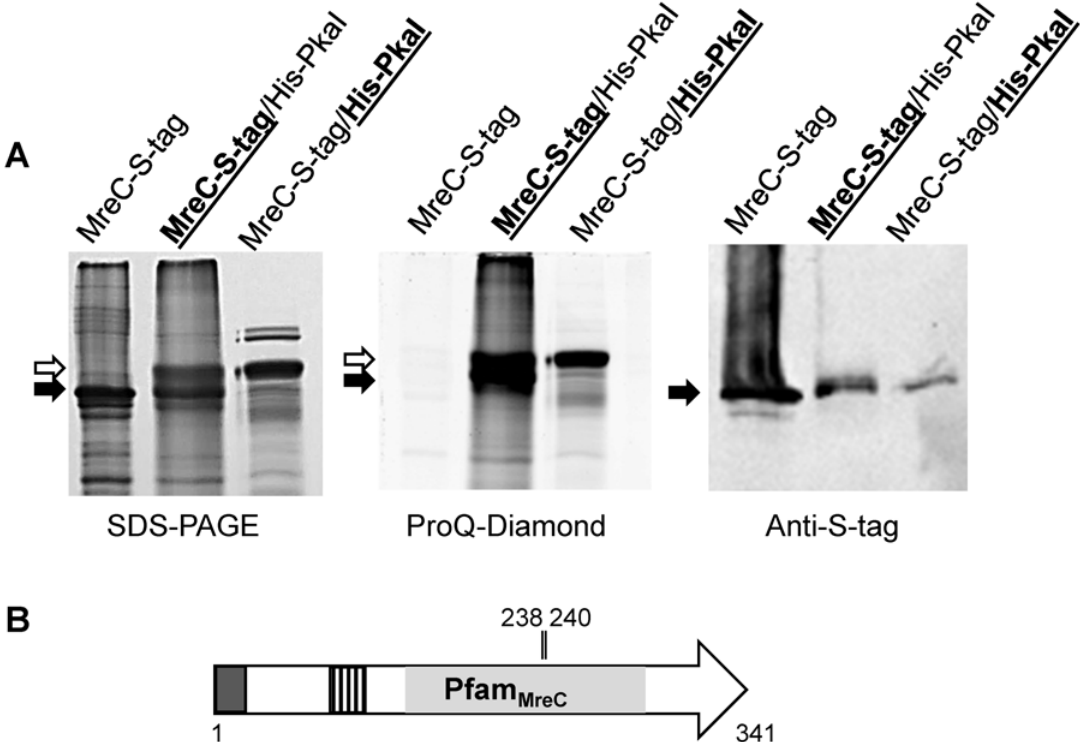
Fig 4. Phosphorylation of MreC by PkaI. S . coelicolor mreC with a S-tag encoding sequence was expressed in E . coli in the absence or presence of pkaI and purified by affinity chromatography (A). PkaI with an N-terminal His-tag was purified by Ni-NTA chromatography in the presence of mreC . Proteins (bold letters and underlining indicate, which protein was purified) were separated on a SDS polyacrylamide gel and stained with Coomassie blue. Purified MreC_S- tag (black arrow) contained considerable amounts of co-purified PkaI (white arrow). Phosphorylated proteins were identified by ProQ Diamond staining. The white arrow indicates autophosphorylated His_PkaI, while the black arrow marks phosphorylated MreC_S-tag. Immunoblotting with Anti-S-tag antibodies confirmed the identity of MreC_S-tag. Domain architecture of S . coelicolor MreC and positions of the most likely phosphosites (B). Predicted Pfam_MreC domain, signal sequence (dark grey box), coil-coil region (hatched box) and position of phosphorylated T residues, identified by LC-MS/MS, are indicated.